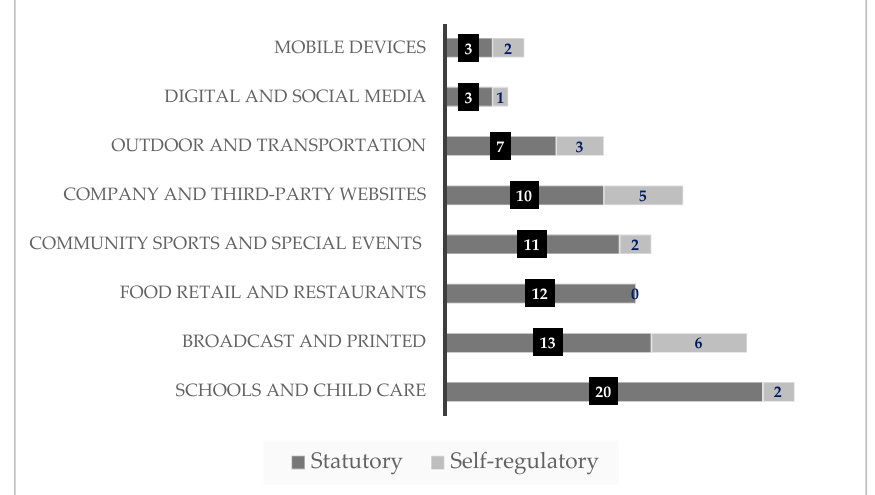
Figure 3. Marketing techniques covered by policies that restrict the marketing of food and beverage products of 14 countries in the Americas Region *. * Data show policy characteristics ( n = 38) of 14 countries of the World Health Organization (WHO) Americas Region, namely, Argentina, Bolivia, Brazil, Canada, Chile, Colombia, Costa Rica, Dominican Republic, Ecuador, El Salvador, Mexico, Peru, Uruguay, and USA.